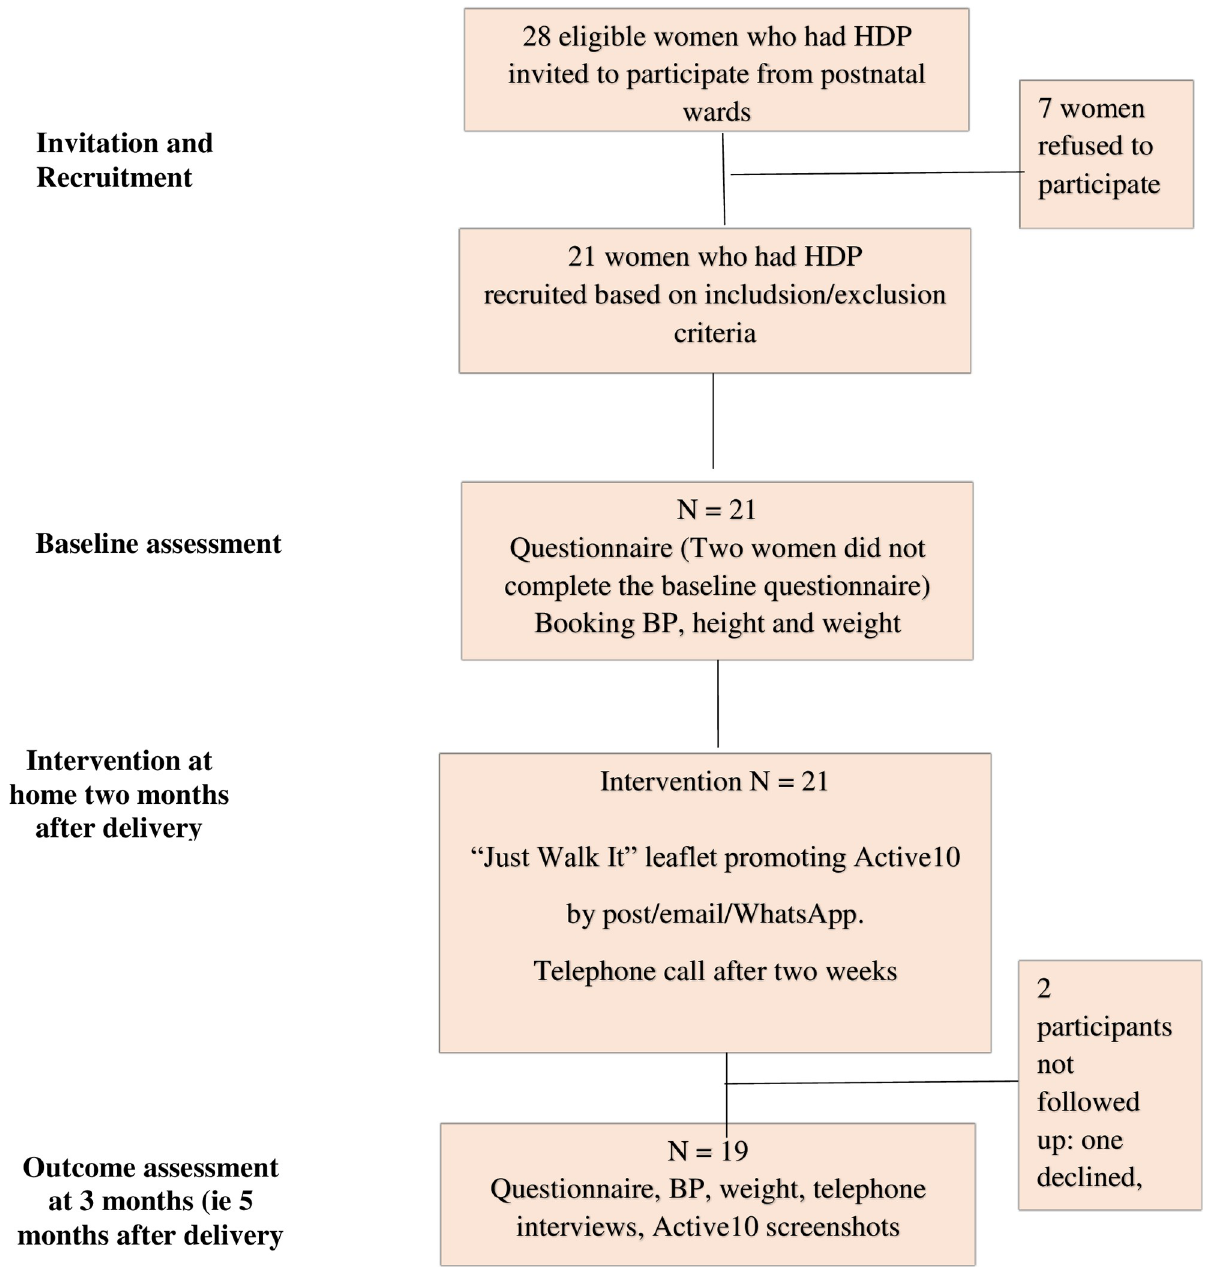
Fig 1. “Just Walk It” feasibility trial flow chart: Use of a brief advice leaflet and the Active10 app to increase brisk walking in mothers who had hypertensive disorders of pregnancy (HDP). https://doi.org/10.1371/journal.pone.0282066.g001 Intervention Two months after delivery, all participants were sent (by post, email and/or WhatsApp based on women’s preferred method of contact as indicated in the consent form) a “Just Walk It” leaflet (S2 Fig ) providing information on the possible benefits of brisk walking after HDP and encouraging them to download the Active10 app and walk briskly for at least 10 minutes per